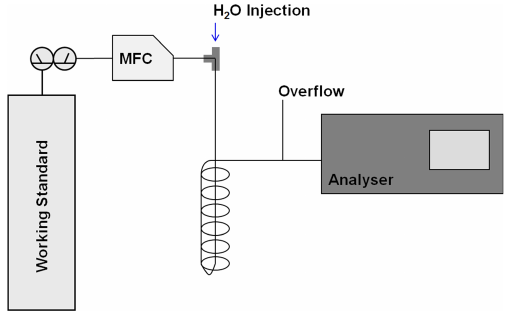
Fig. 7. Experimental setup for the determination of the water vapour interference.